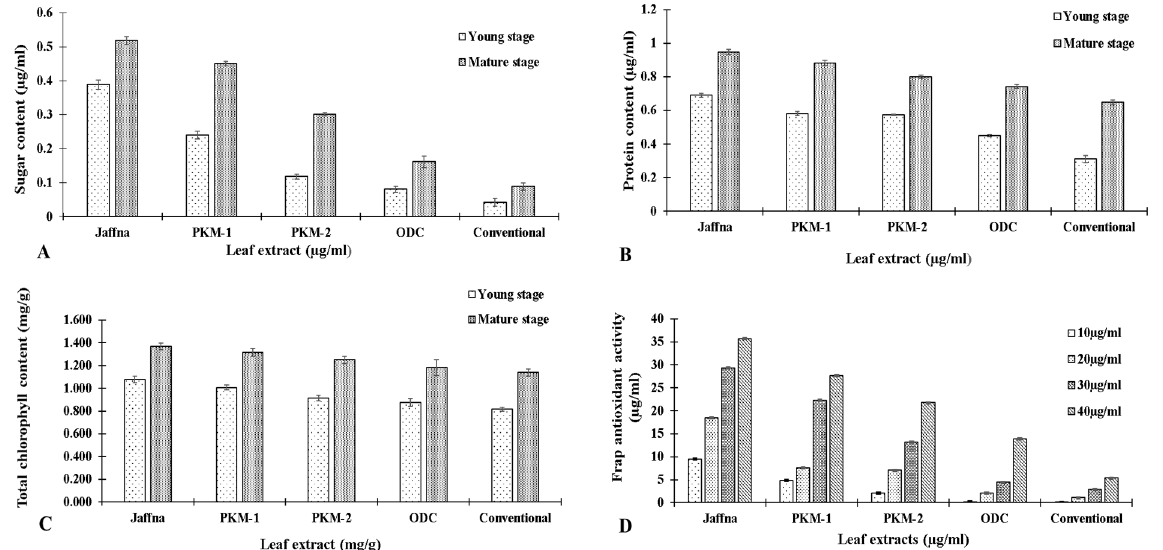
Figure 1. Estimation of biochemical characteristics of five different varieties of M. oleifera : ( A ) sugar content, ( B ) protein content, ( C ) total chlorophyll content, and ( D ) FRAP antioxidant activity.